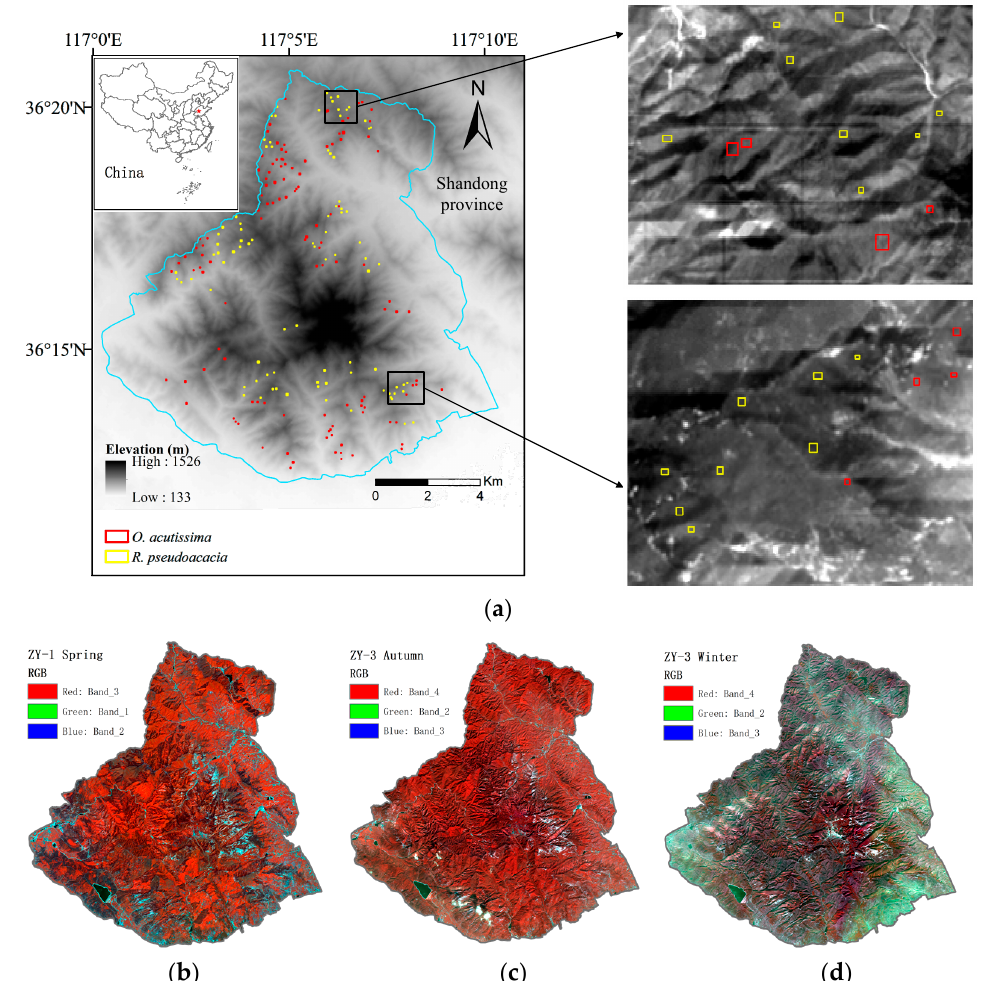
Figure 1. ( a ) Location map of the study region and images of the sample area. ( b ) Spring image; ( c ) autumn image; ( d ) winter image.